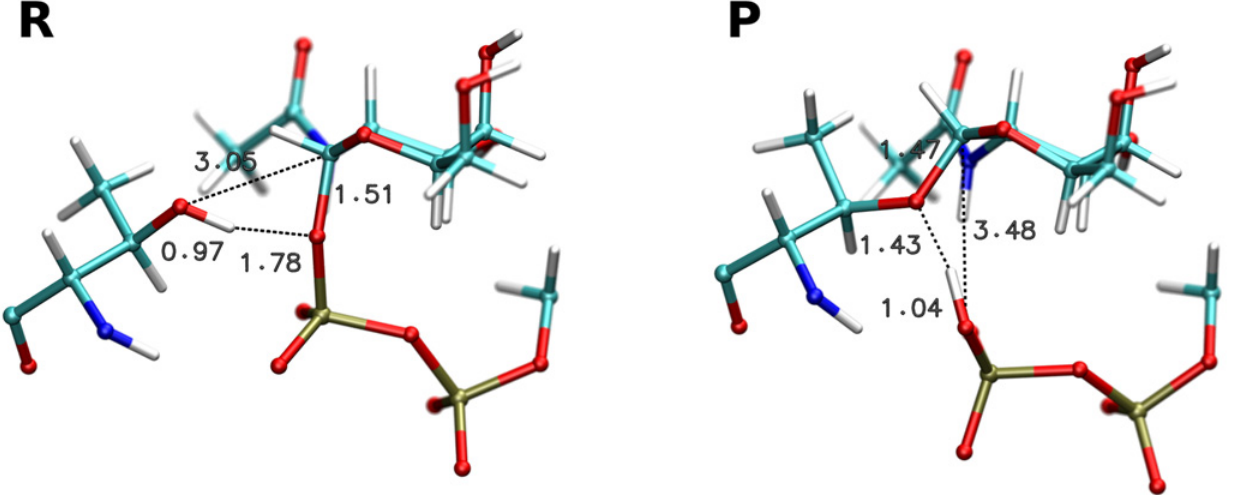
Fig 2. Optimized reactant and product structures.